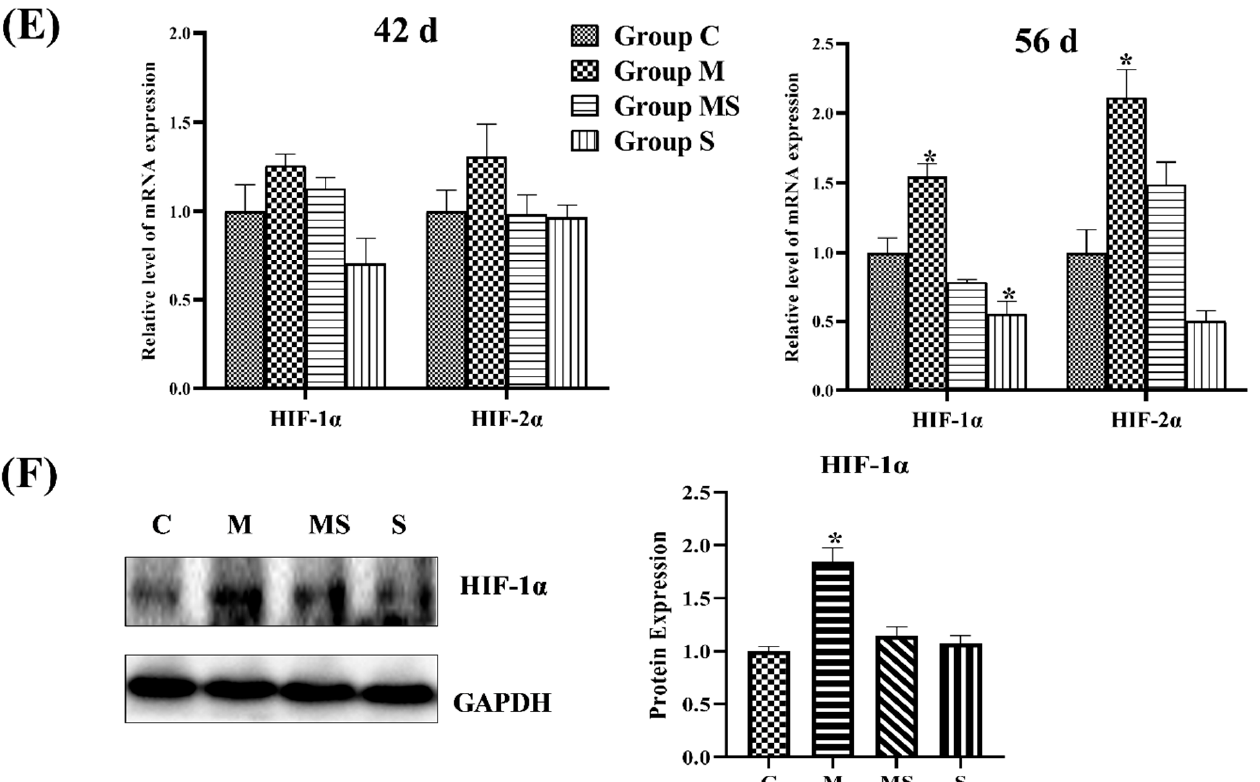
Figure 4. The changes in cartilage homeostasis and the HIF pathway in articular cartilage. ( A ) The 42 d and 56 d RNA expression of catabolic related genes in articular cartilage. ( B ) The 42 d and 56 d RNA expression of anabolic related genes in articular cartilage. ( C ) The changes in serum catabolic cytokines (IL-1 β and IL-6) and anabolic cytokines (VEGF and IGF-1) in four groups at the age of 42 d and 56 d. ( D ) The 56 d protein expression of homeostasis-related factors in articular cartilage. ( E ) The 42 d and 56 d mRNA expressions of HIF pathway in articular cartilage. ( F ) The 56 d protein expressions of HIF-1 α in articular cartilage. Here, * p < 0.05 vs. control group.